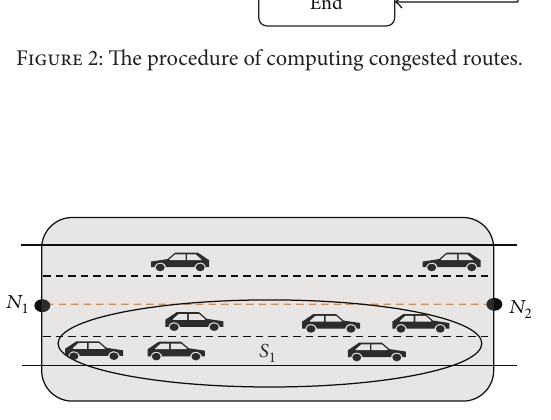
Figure 3: The road segment between nodes 𝑁 1 and 𝑁 2 in a road